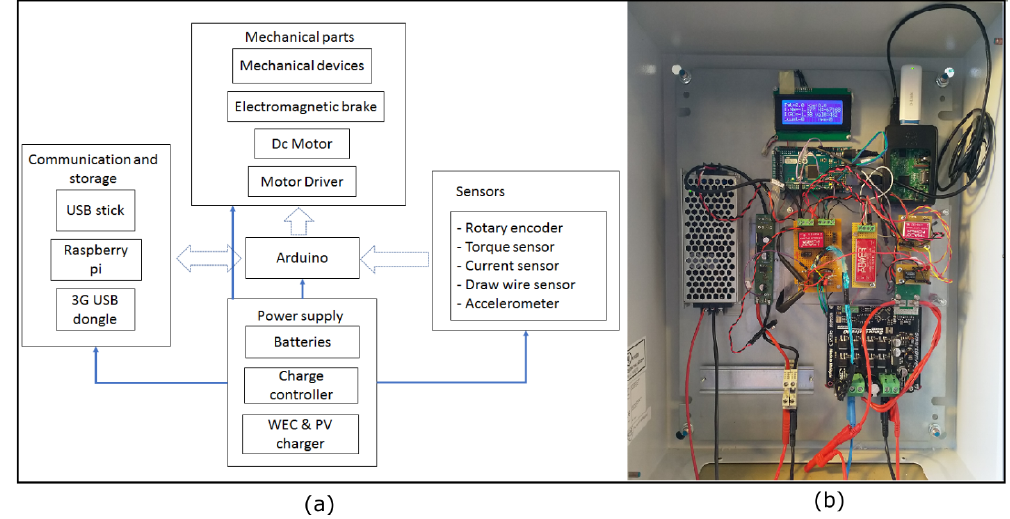
Figure 2. ( a ) Schematic of the compensator system [16]. ( b ) Electrical connection installed in the metal